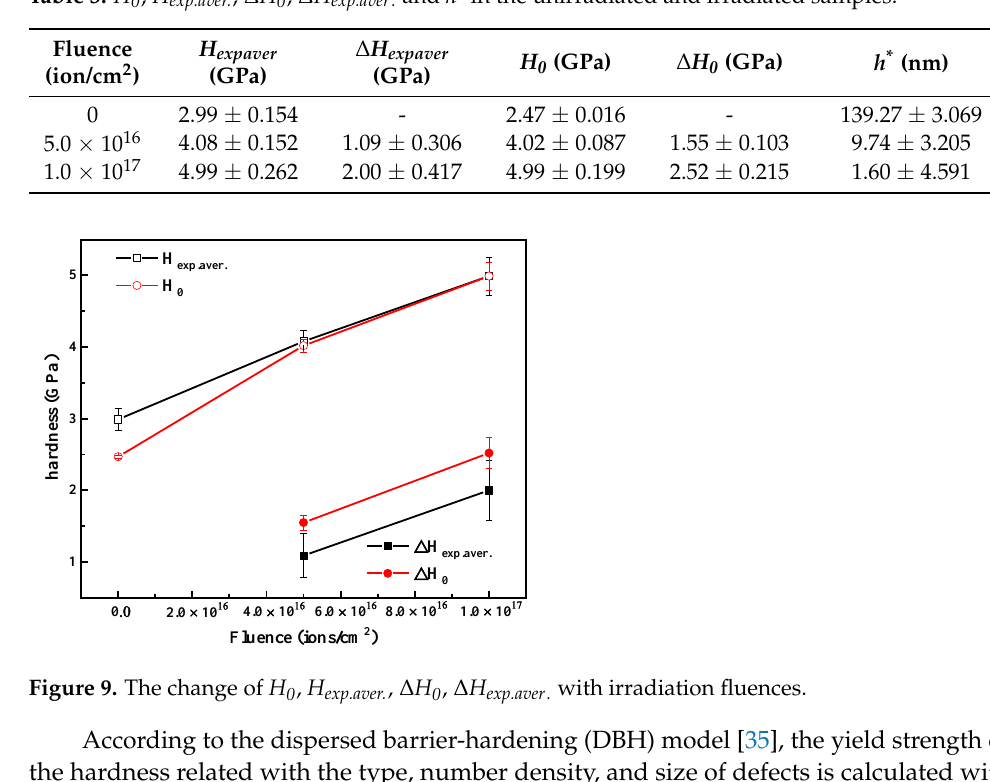
Table 3. H 0 , H exp.aver. , ∆ H 0 , ∆ H exp.aver . and h * in the unirradiated and irradiated samples.